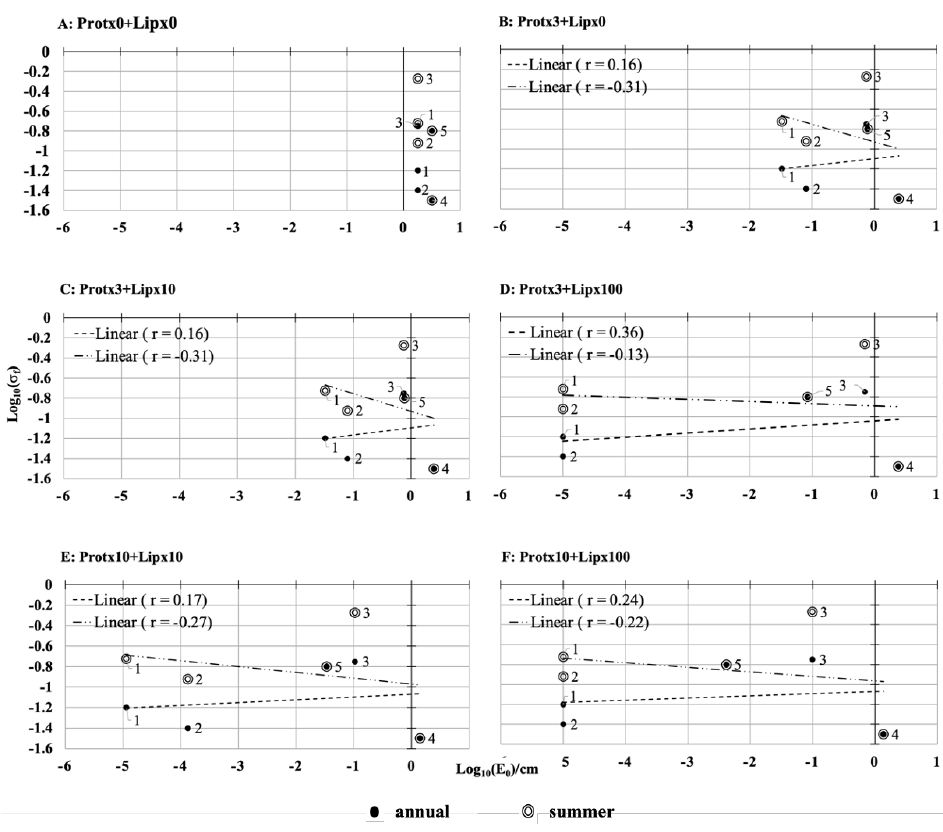
Figure 4. Annual ( • ) and summer ( ) log Sigma-0 frequency vs. the log of capillary wave height when the protein (Prot) and lipid (Lip) concentrations are scaled by varying amounts. ( A ) no surfactants ( B ) baseline protein ×3 but no lipids, ( C ) baseline protein ×3 and baseline lipid ×10, ( D ) baseline protein ×3 and baseline lipid ×100, ( E ) baseline protein ×10 and baseline lipid ×10, ( F ) baseline protein ×10 and baseline lipid ×100. All computations were performed at the surface pressure threshold value of 3 mNm − 1 .